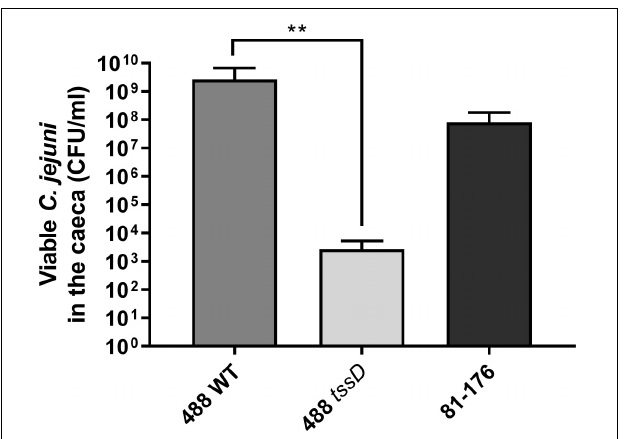
FIGURE 7 | Infection of broiler chickens with the 488 wild-type strain, 488 tssD mutant or 81–176 wild-type strain. Ten 15-day old Ross 308 broiler chickens were inoculated with approximately 1 × 10 8 CFU/ml of either the 488 wild-type strain, the 488 tssD mutant or the 81–176 wild-type strain. Chickens were euthanized 3 days post-infection. Caecum contents were plated and counts of viable C. jejuni in the samples performed. Asterisks denote a statistically significant difference ( ∗∗ p ≤